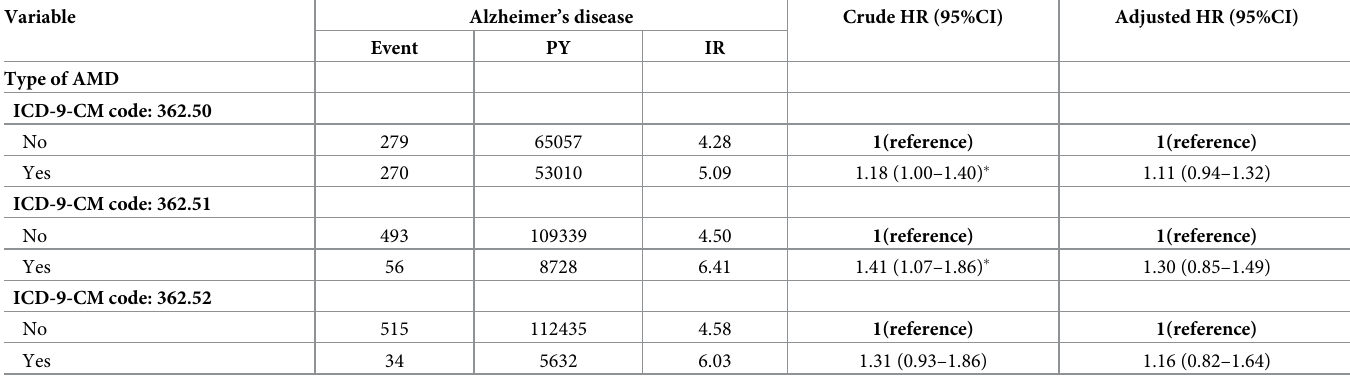
Table 4. Incidence rates, hazard ratios, and confidence intervals of Alzheimer’s disease among different type of AMD. Variable